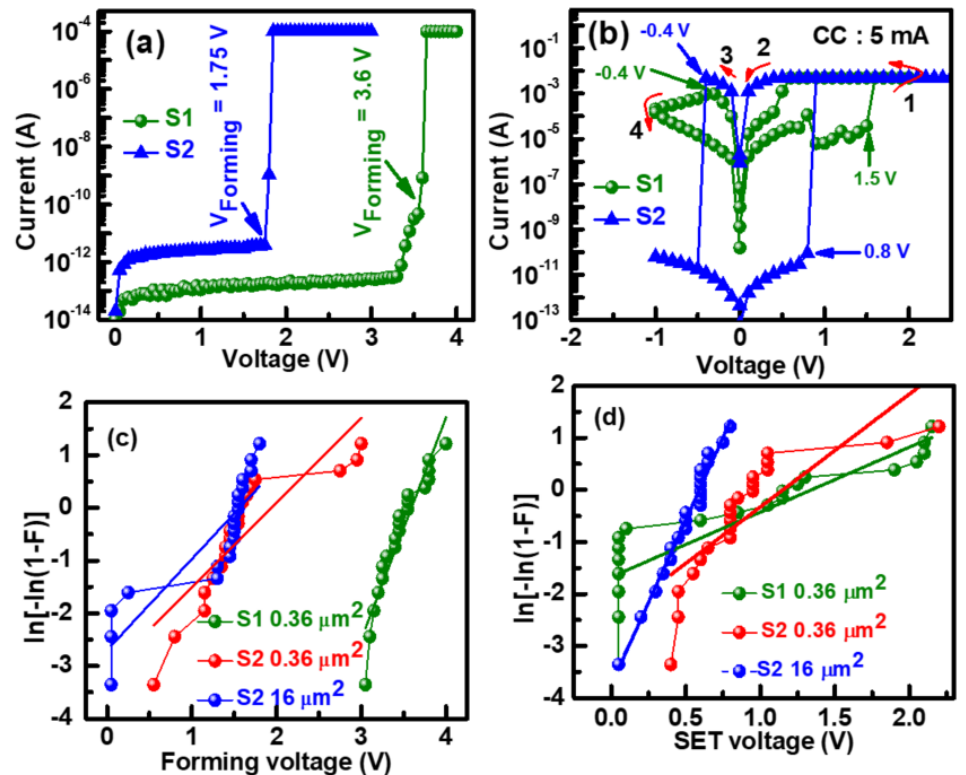
Figure 3. ( a ) Typical forming cycle of the pristine S1 and S2 devices and ( b ) I-V switching characteristics of the S1 and S2 devices under CC of 5 mA. Weibull distribution plots of the S1 and S2 devices to study the ( c ) device-to-device forming voltage and ( d ) SET voltage variations by using linear fitting.